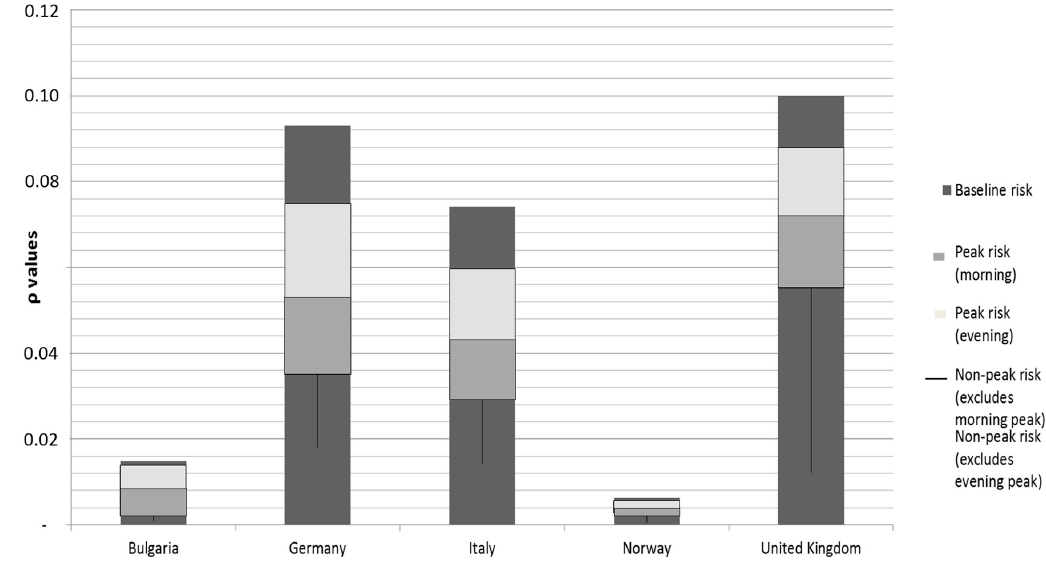
Figure 5. Overall country contribution to aggregate risk of peak electricity demand.